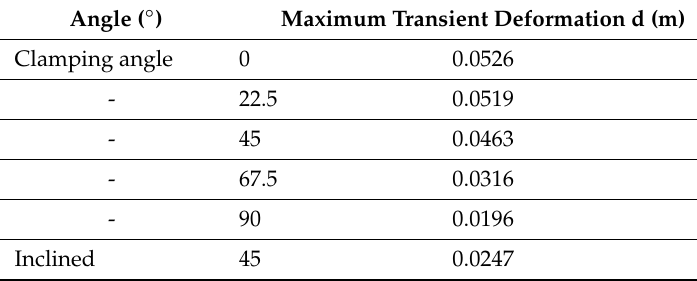
Table 2. Deformation across flap